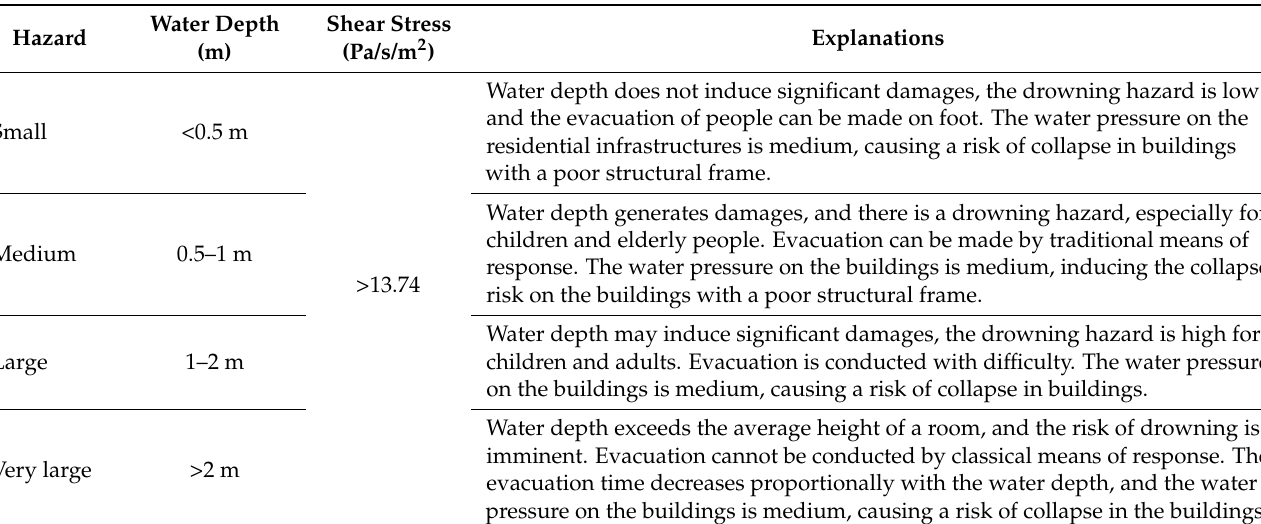
Table 2. The hazard classes used for risk